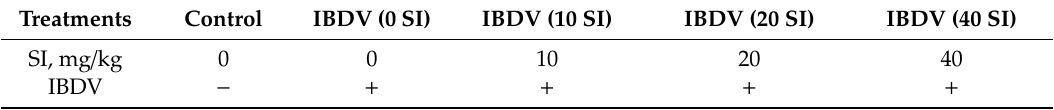
Table 2. The design of the experimental